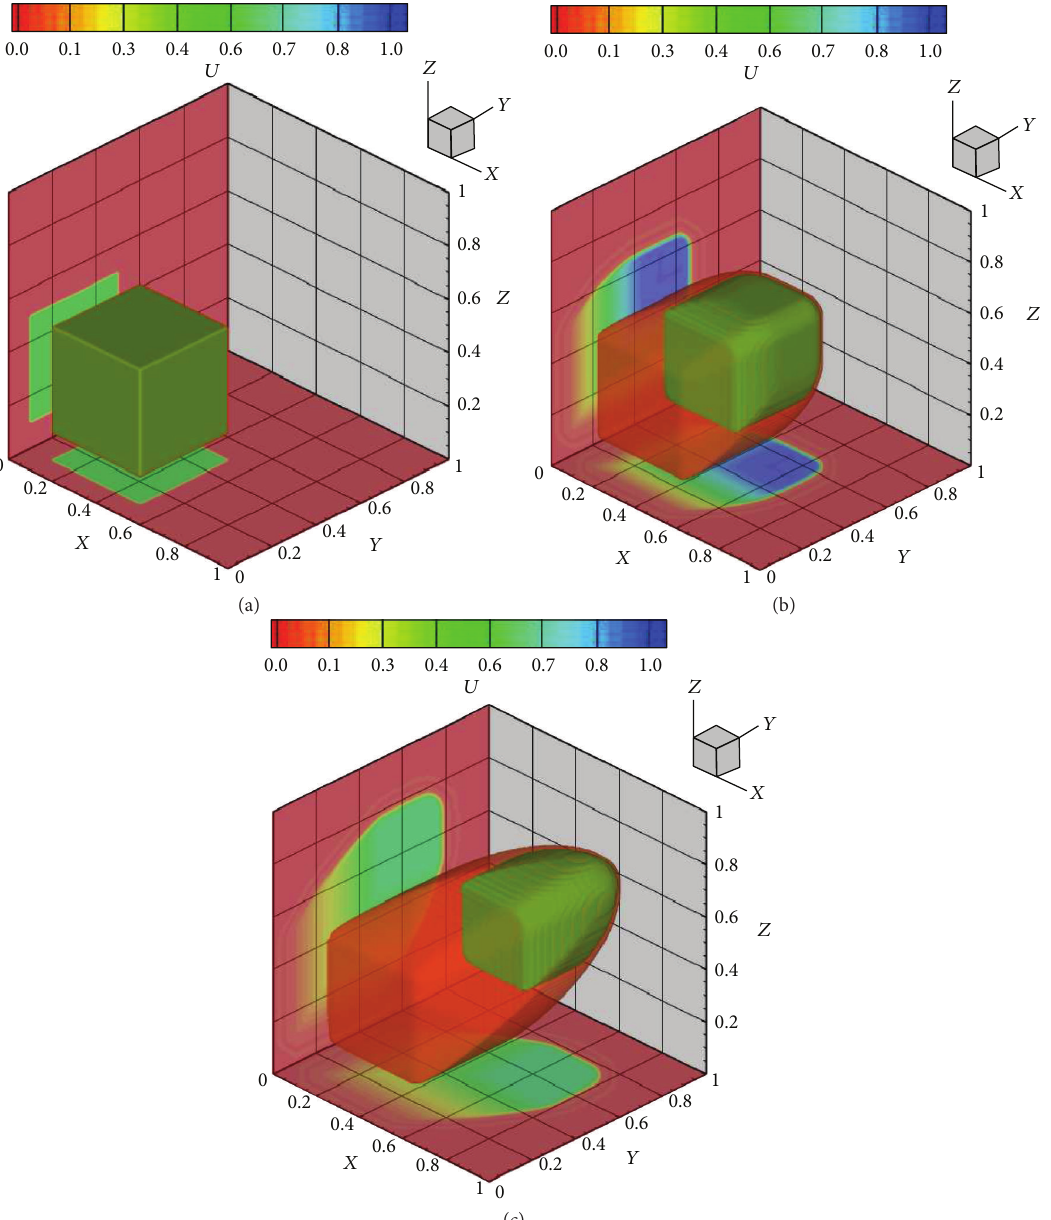
Figure 5: Instantaneous solutions of the nonlinear scalar equation (19) using the CWENO polynomial reconstruction diagonal smoothing at times (a) 𝑡 = 0 , (b) 𝑡 = 0.4 , and (c) 𝑡 = 0.8 . Shown are isosurfaces at two values 0.5 and 0.05 , along with slices along 𝑋 = 0.3 and 𝑍 = 0.3 , which are projected to the end of the domain. Initial condition— 𝑢 = 0.5 , for 0.1 ≤ 𝑥 ≤ 0.5 , 0.1 ≤ 𝑦 ≤ 0.5 , and 0.1 ≤ 𝑧 ≤ 0.5